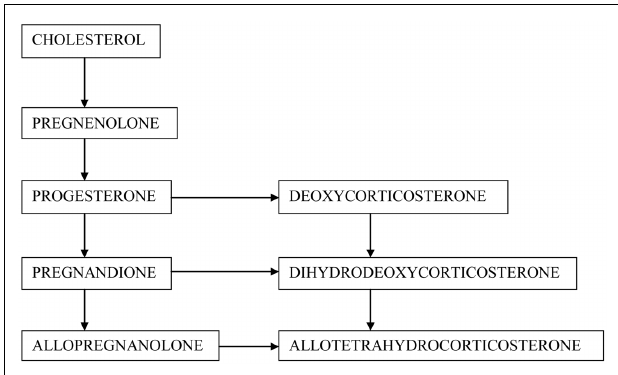
FIGURE 1 | Schematic synthesis of neurosteroids in the CNS.